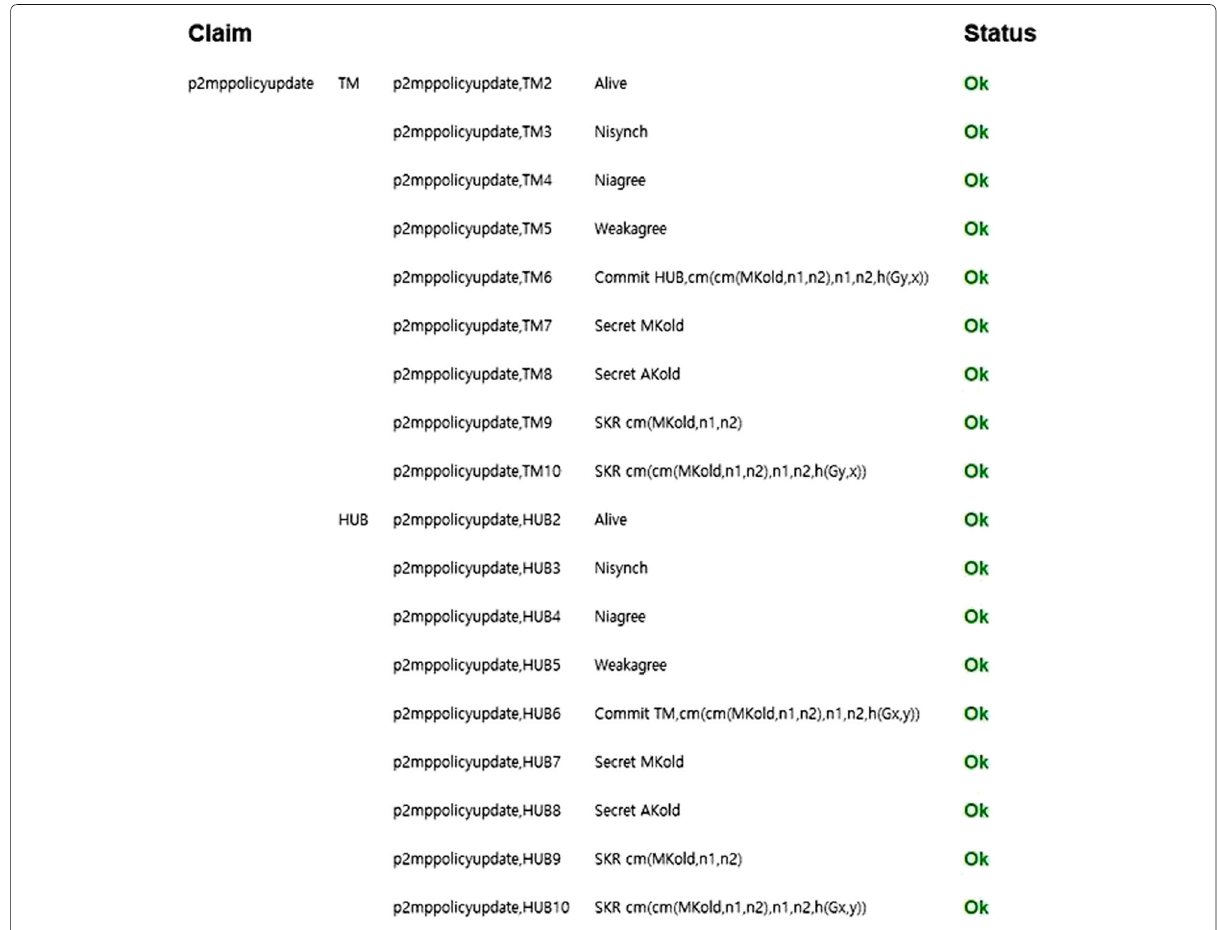
Fig. 8 Verification result of the policy update phase